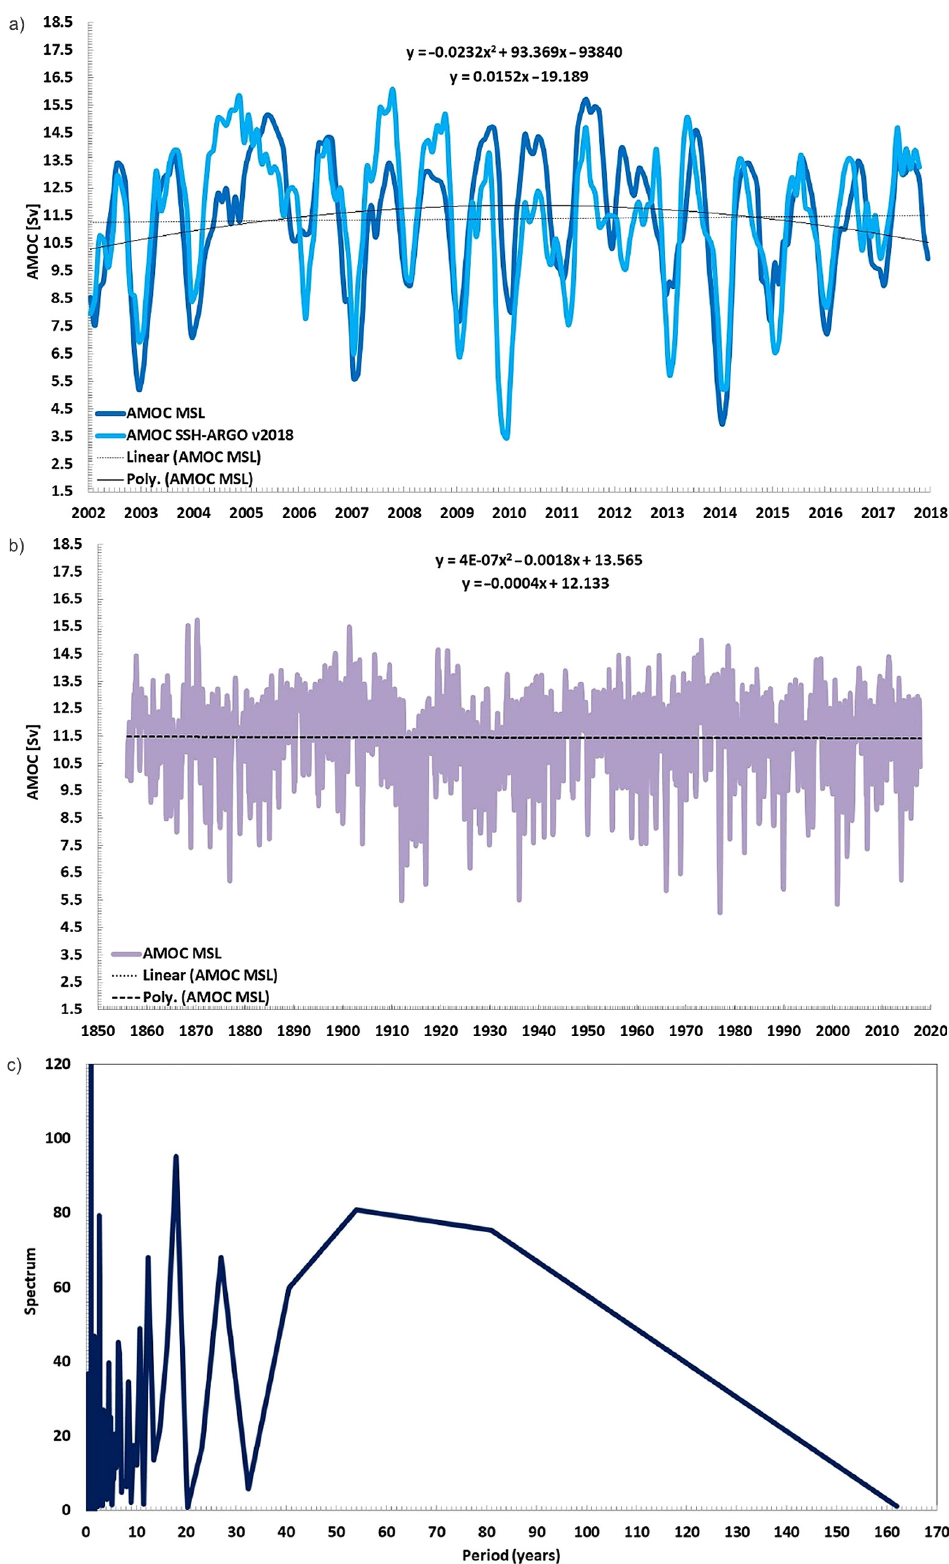
Fig. 3. The Atlantic Meridional Overturning Circulation time series: a) AMOC SSH+ARGO and AMOC MSL since the year 2002 (time series is updated to August 2017), b) AMOC MSL since the year 1856 (time series is updated to December 2017), c) periodogram of the AMOC MSL. The time series represents three-month running